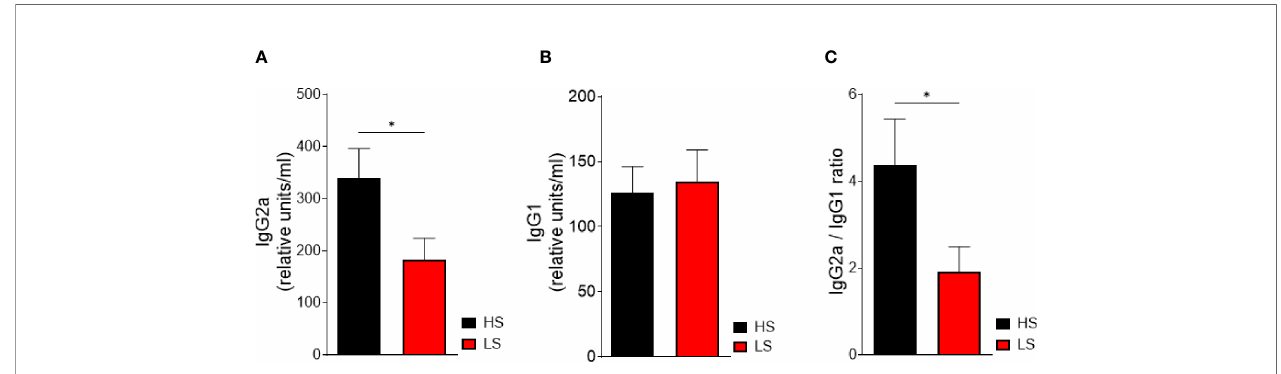
FIGURE 6 | Low-salt diet decreases pathogenic anti-CII IgG2a antibody production and points toward a more Th2-dependent immune response. Serum levels of anti-CII-IgG2a (A) and anti-CII-IgG1 (B) were analyzed by ELISA in mice undergoing LS and HS diet for 62 days (HS, n = 16; LS, n = 16). For normalization, a standard was generated containing high titers of anti-CII antibody sera and considered equivalent to 100 arbitrary units/ml. (C) The ratio of anti-CII IgG2a to anti-CII IgG1 concentration was determined. * p < 0.05. p -values were calculated by Student ’ s t -test. All data were expressed as ± SEM.